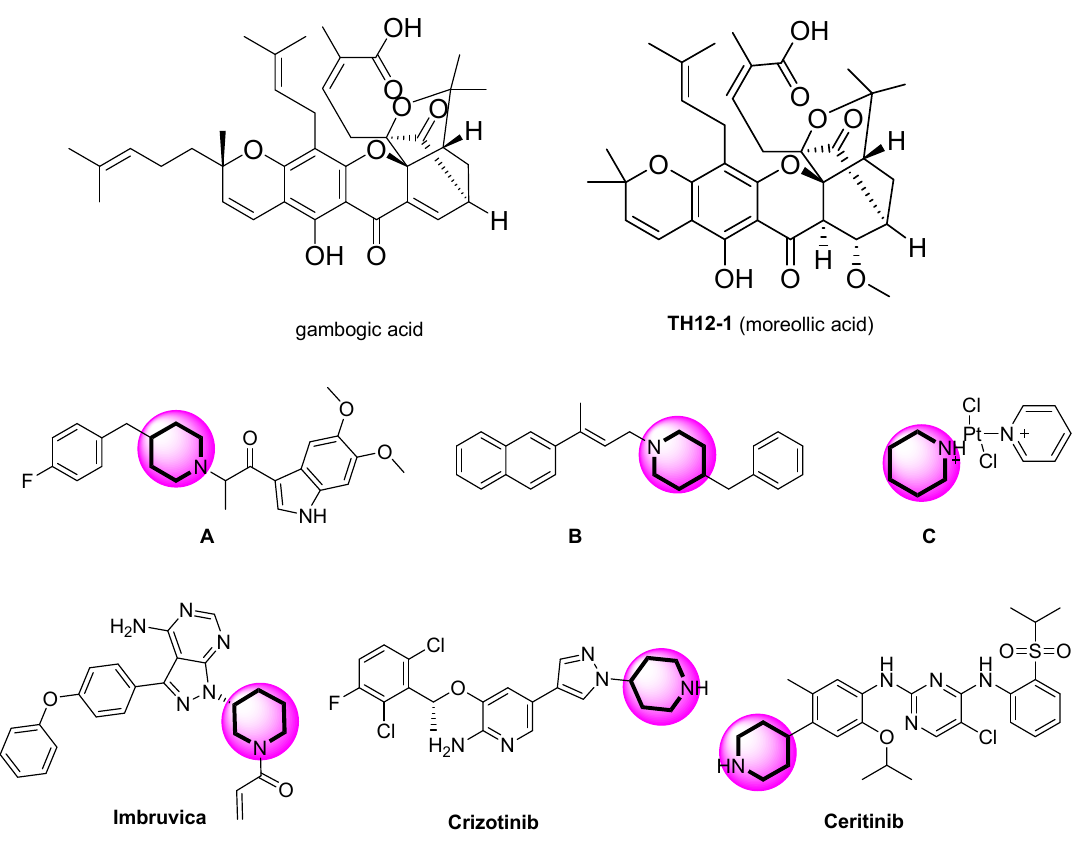
Figure 1. The structures of gambogic acid, moreollic acid, and active compounds containing the piperidine ring.